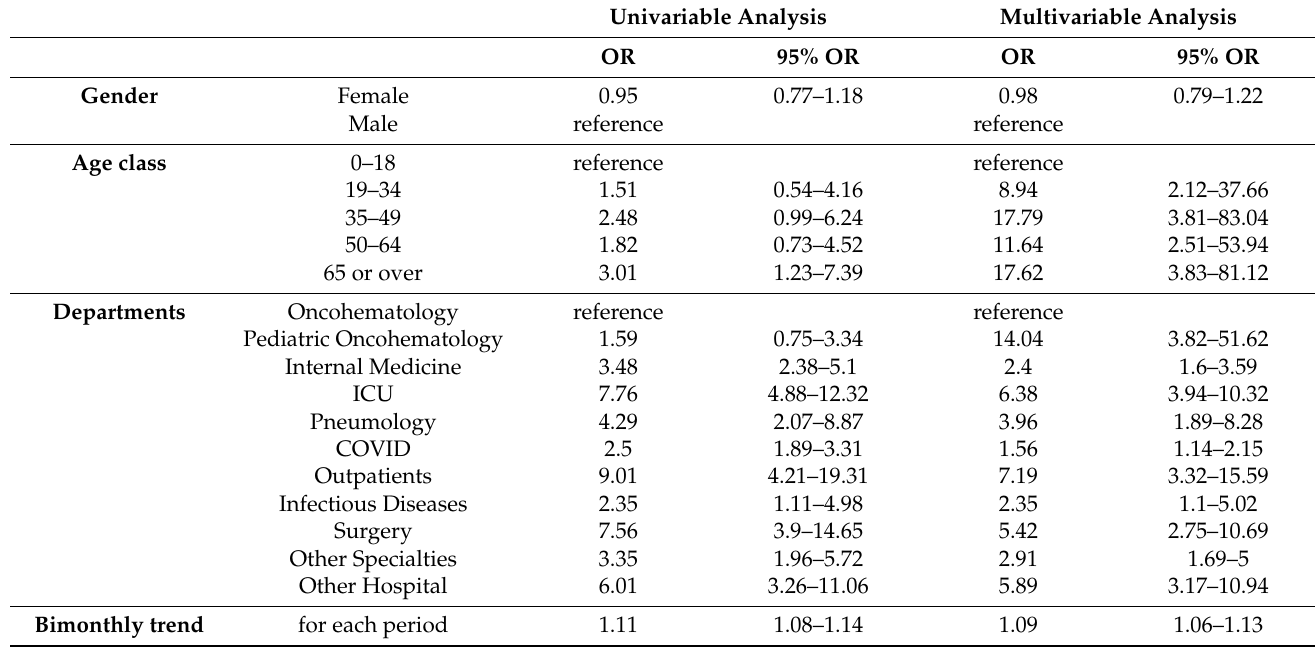
Table 2. Odds ratios (ORs) and 95% confidence intervals determined by logistic